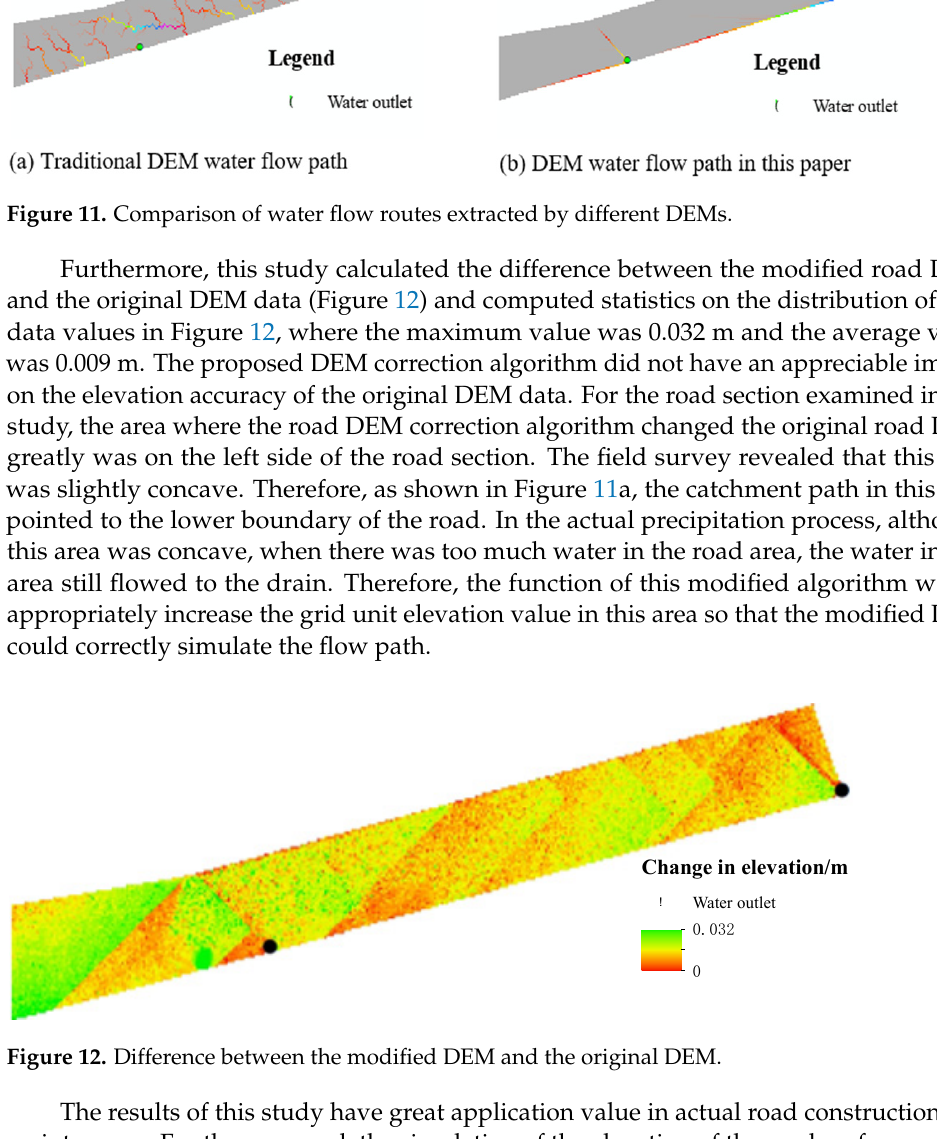
Figure 12. Difference between the modified DEM and the original DEM.